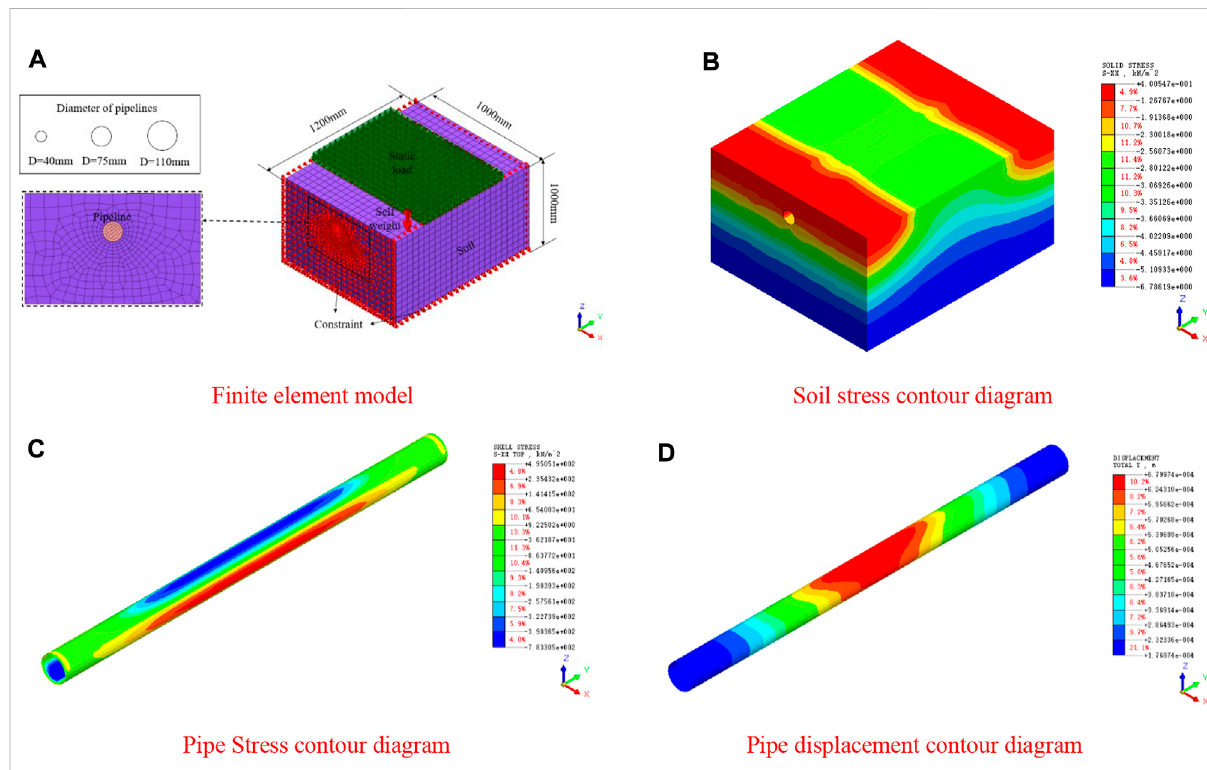
the fi nite element model, and corresponding results are shown in Figure 7. The model involves the de fi nition of two kinds of material